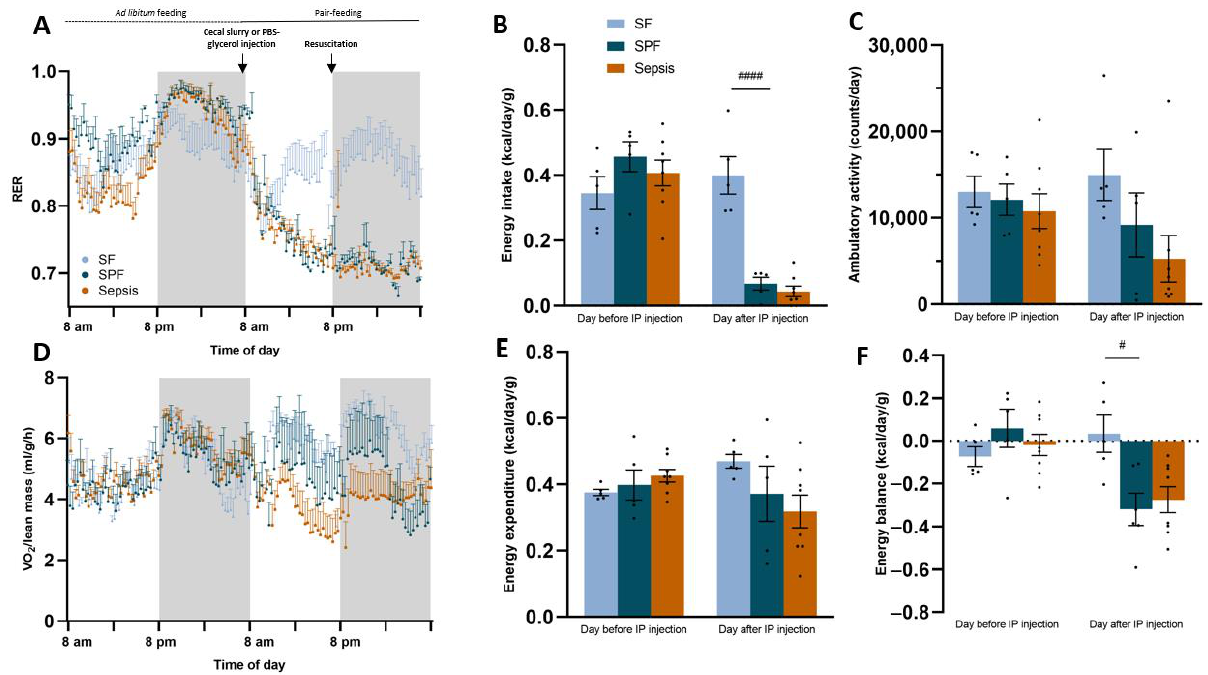
injection. ( B ) Daily energy intake was drastically reduced in SPF and Sepsis groups after IP injection (see Figure S3 for the food intake expressed in grams of pellets per day). ( C – E ) Ambulatory activity, systemic oxygen consumption (VO 2 ) normalized to lean mass, and daily energy expenditure tended to decrease in SPF compared with SF mice, but were not different between SPF and Sepsis mice after IP injection. ( F ) Daily energy balance was lower in the SPF group than the SF group and negative in the SPF and Sepsis groups, resulting in an energy deficit in the SPF and Sepsis groups. Light-blue bars for the SF group (n = 5), dark-blue bars for the SPF group (n = 5), and orange bars for the Sepsis group (n = 8). Data are expressed as mean values with SEM and compared using a Kruskal–Wallis test with post hoc Dunn’s test. # SPF vs. SF and * Sepsis vs. SPF. # p < 0.05, #### p <